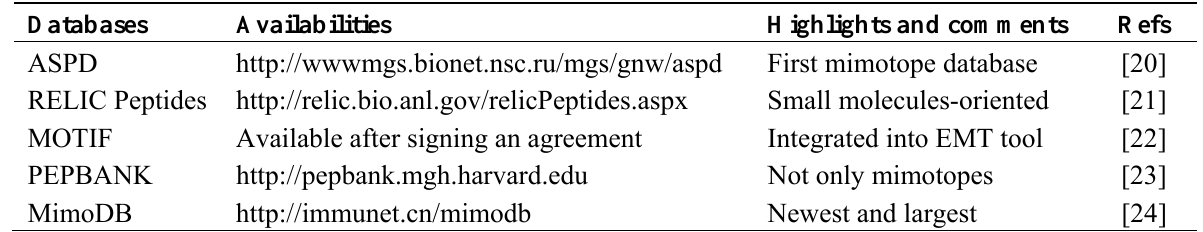
Table 1. Databases for mimotope